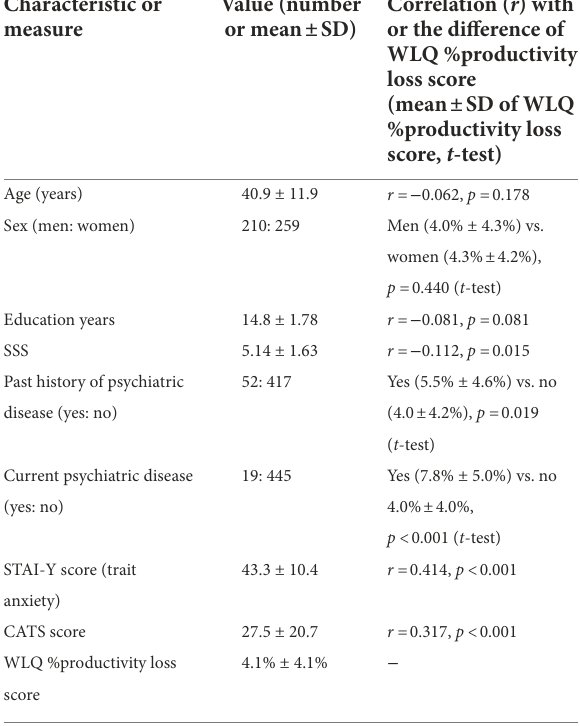
TABLE 1 Patient characteristics, STAI-Y, CATS, and SSS scores and their association with WLQ %productivity loss score. Characteristic or measure